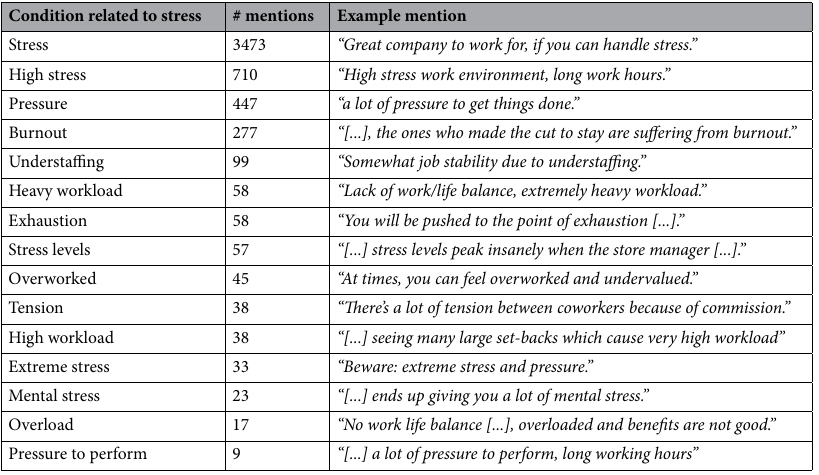
Table 2. Top15 most frequent stress-related mentions identified on a company review site, and their frequency counts.